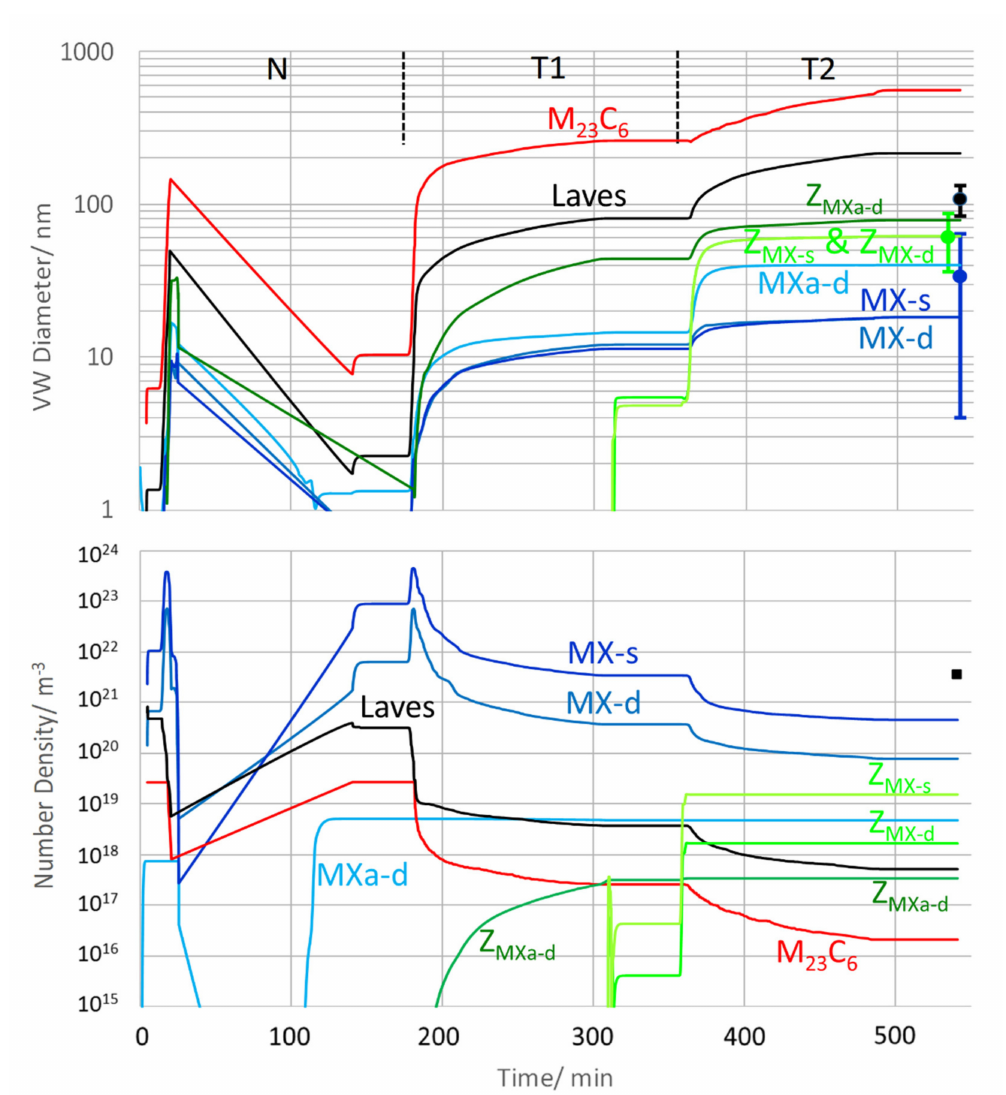
Figure 10. Simulated volume-weighted (VW) diameters and number densities during N + T of Z6 vs. TEM data from Table